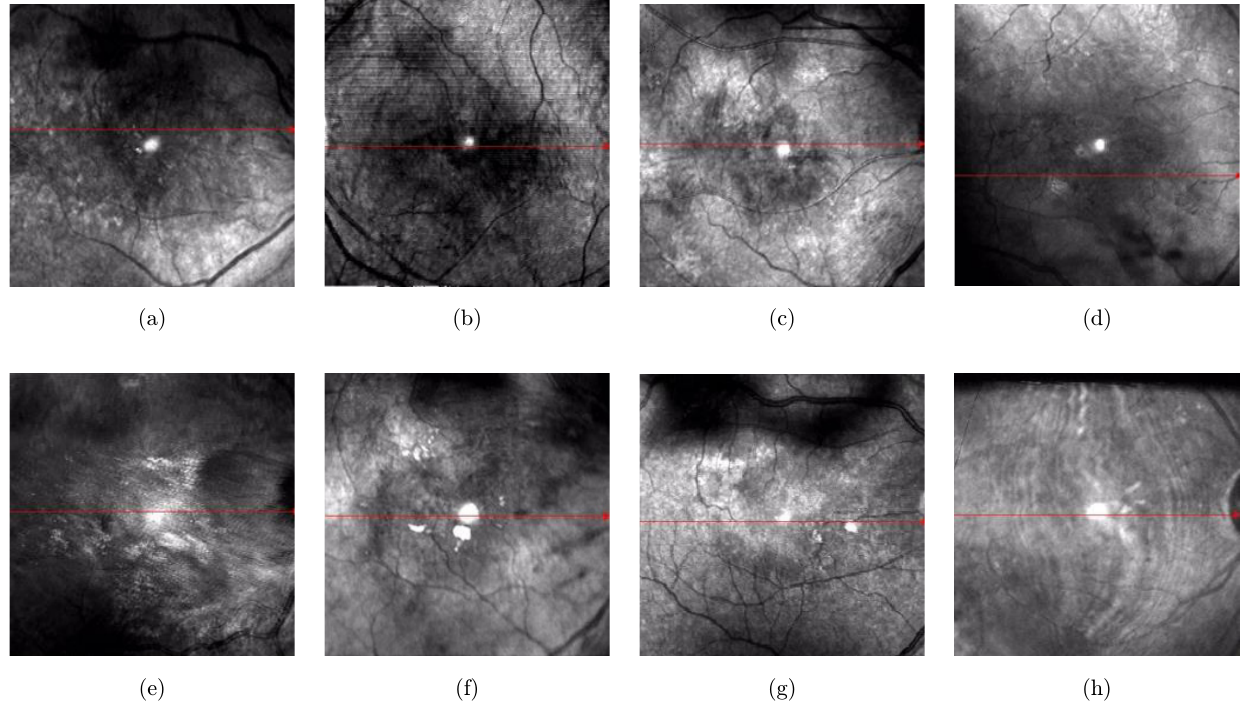
Fig. 7. (a) Very severe NPDR with CSME, (b) moderate NPDR without CSME, (c) severe NPDR with CSME, (d) NODR, (e) PDR with vitreous hemorrhage with macular edema, (f) PDR with CSME, (g) mild NPDR with CSME, and (h) PDR with